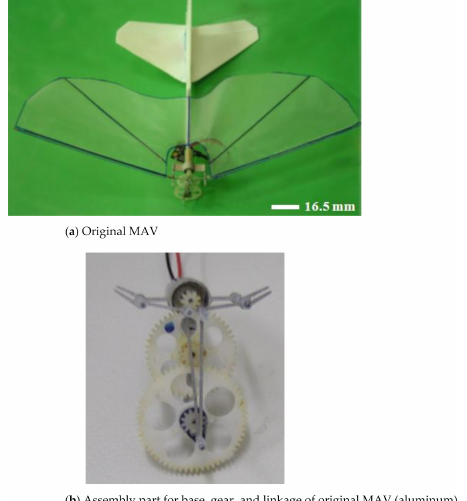
Figure 1. Product of the original flapping-wing